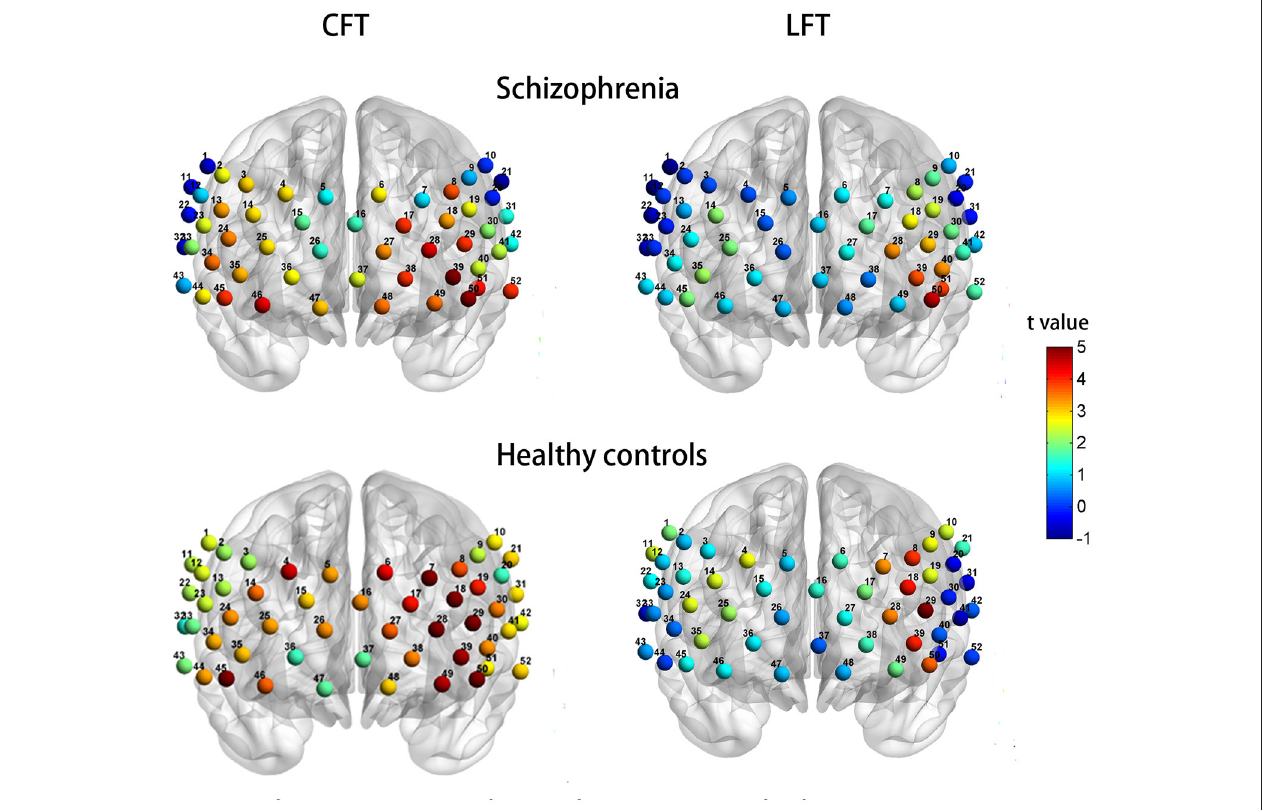
FIGURE 4 | Patterns of cortical activation during the CFT (left column) and LFT (right column) for patients with schizophrenia (top row) and healthy controls (bottom row)